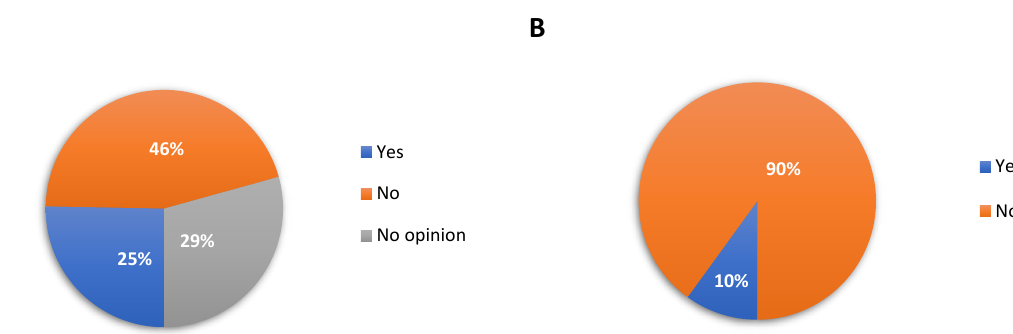
Figure 3. Satisfaction with a doctor’s appointment in the form of teleconsultation, e-prescription, and need for assistance in purchasing prescription drugs from e-prescription in pharmacy and making an appointment with a doctor. ( A ) Satisfaction with teleconsultation, ( B ) The need for assistance when using teleconsultation or e-prescription.